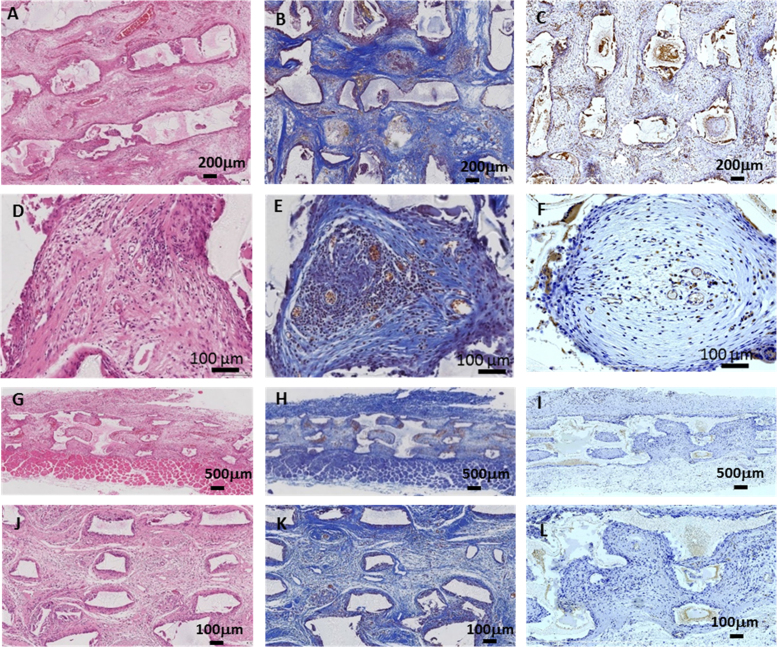
Subcutaneous implantation of 50RTC+H scaffolds at week 12: (A) tissue integration of middle-in-plane of the 50RTC+H scaffold by Hematoxylin and Eosin (H&E) staining, (B) collagen production by Masson׳s trichrome staining, (C) endothelial cell infiltration as identified by CD31 staining, used as a marker of angiogenesis; (D-F) enlarged middle-in-plane views respectively. (G-I) Middle cross-sectional view and (J-L) enlarged middle cross-sectional view.